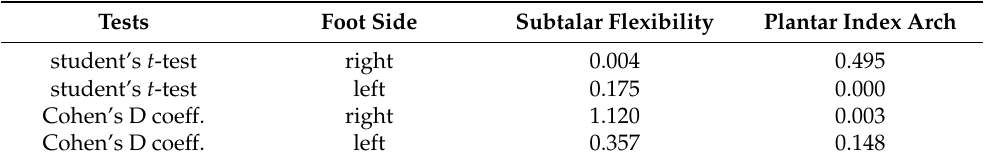
Table 7. p value (student’s t -test) * and Cohen’s D coefficient ** for parameters variations at EV2 comparing tje two groups.